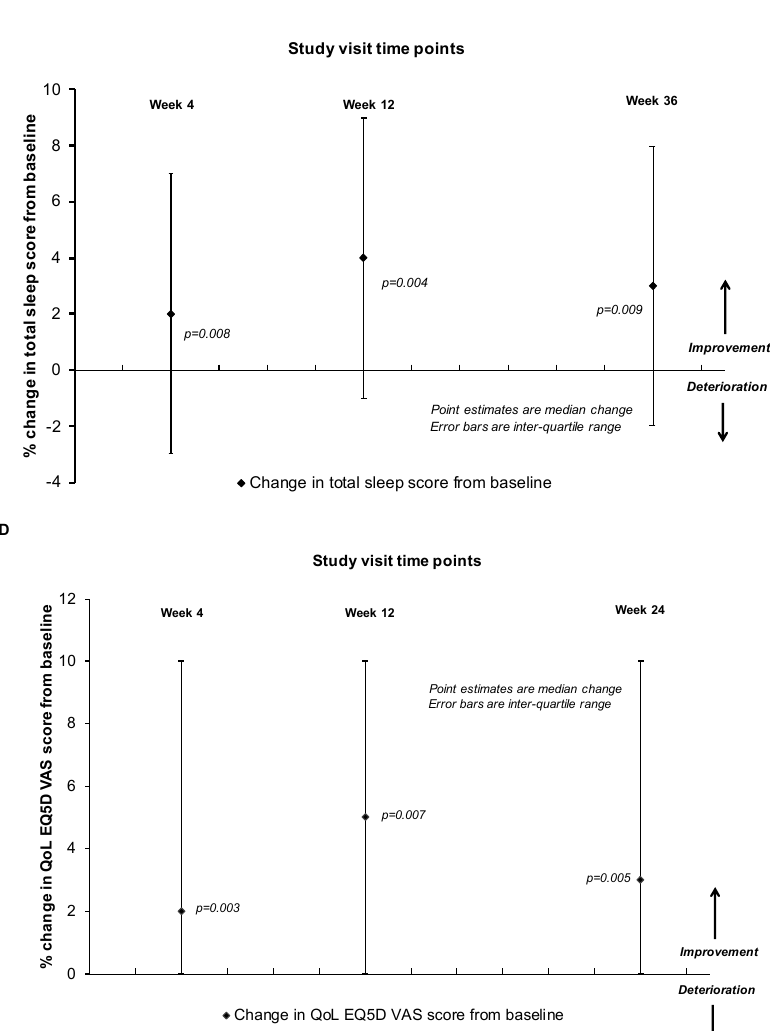
Figure 1. Change in patient reported outcomes for anxiety ( A ), depression ( B ), sleep ( C ) and health related quality of life scores ( D ) at 4, 12 and 24 weeks from baseline. HAD = hospital anxiety and depression scale, QoL = quality of life. Point estimates are median change; error bars are IQR change following the Wilcoxon rank test.